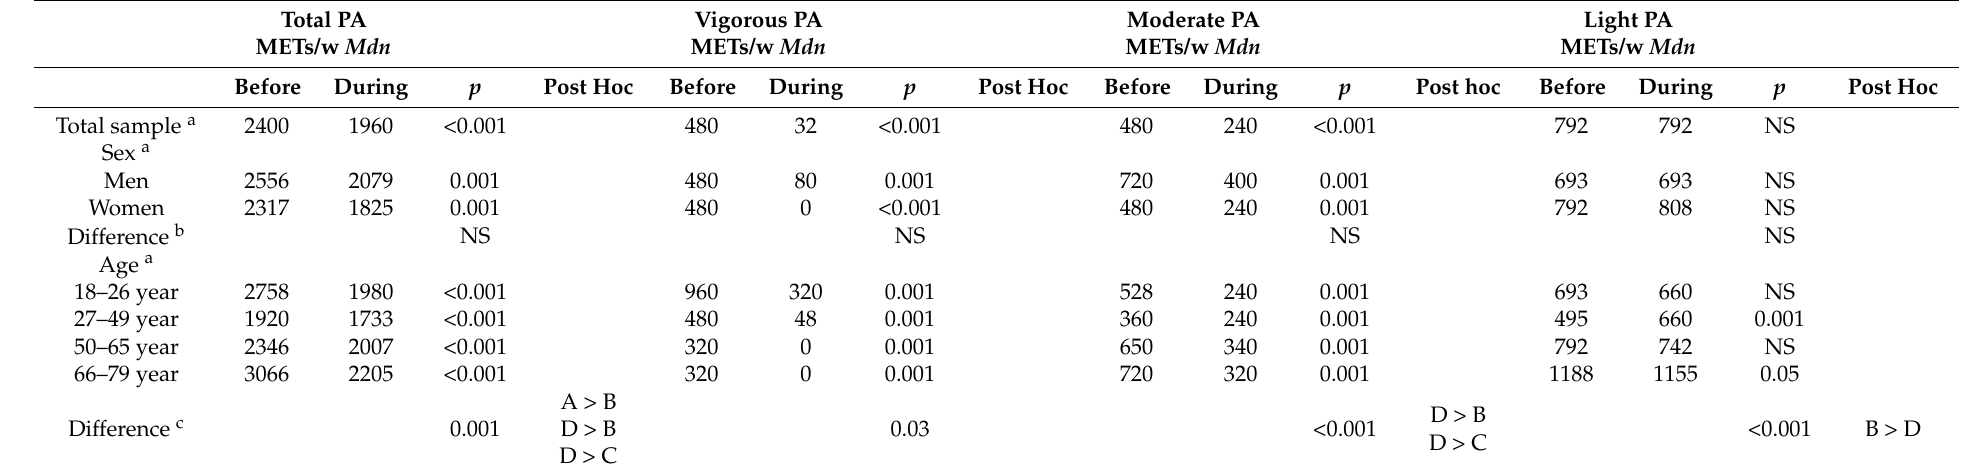
Table 2. PA before and during the pandemic for the total sample and in relation to sex and